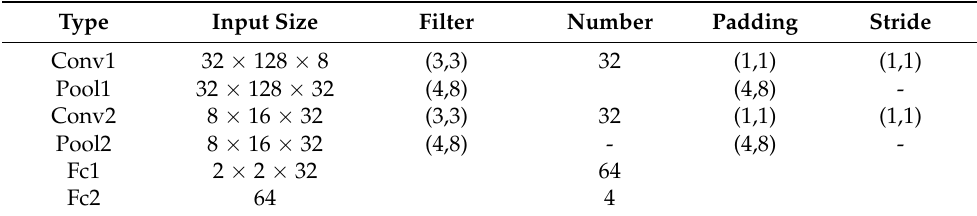
Table 4. Final deep CNN structure